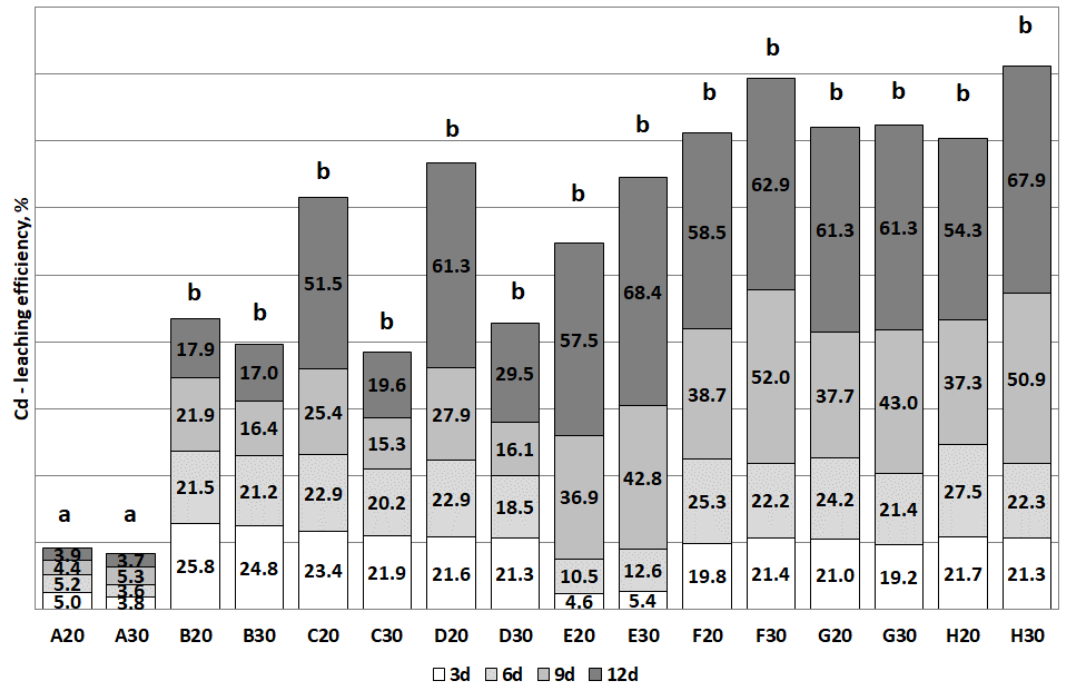
Figure 8. Bioleaching e ffi ciency of Cd during the experiment (Statistical groups a and b ).